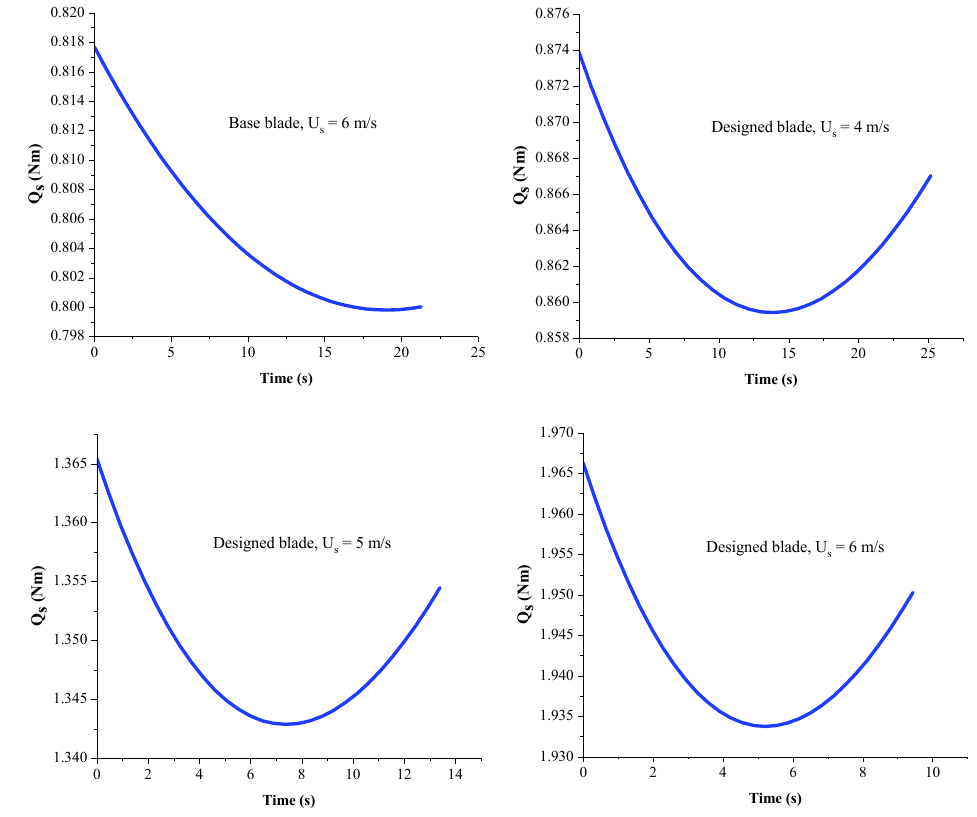
Figure 22. Variations of the Q s up to 𝜆 = 2 for the designed and base blades.